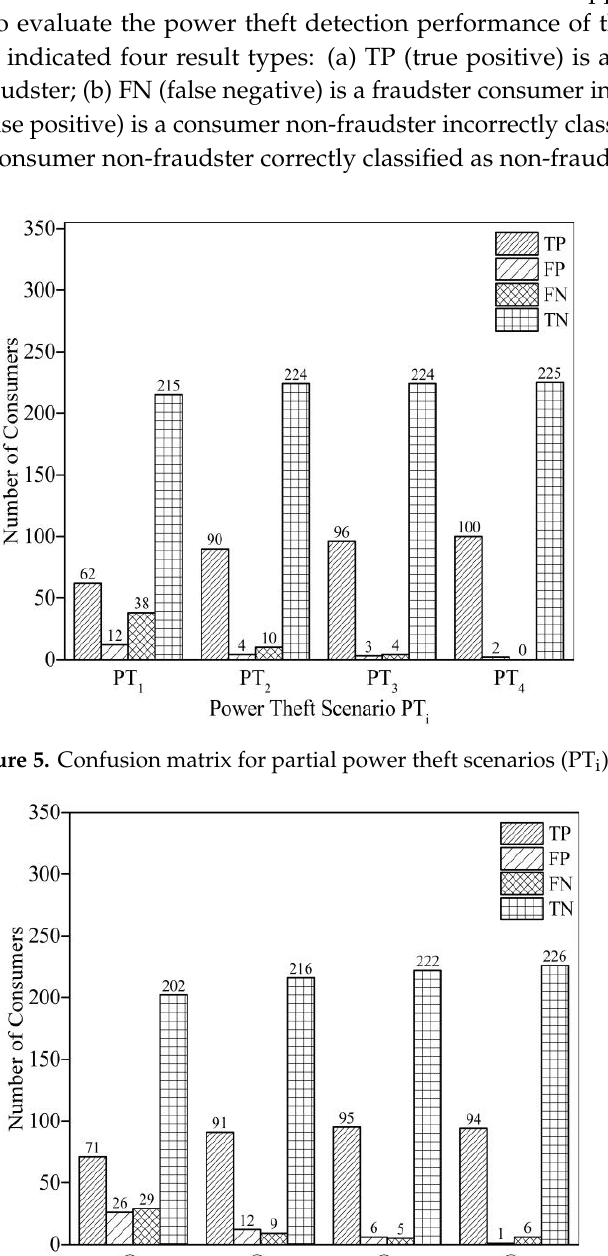
Figure 4. Ranking of the selected classification features.